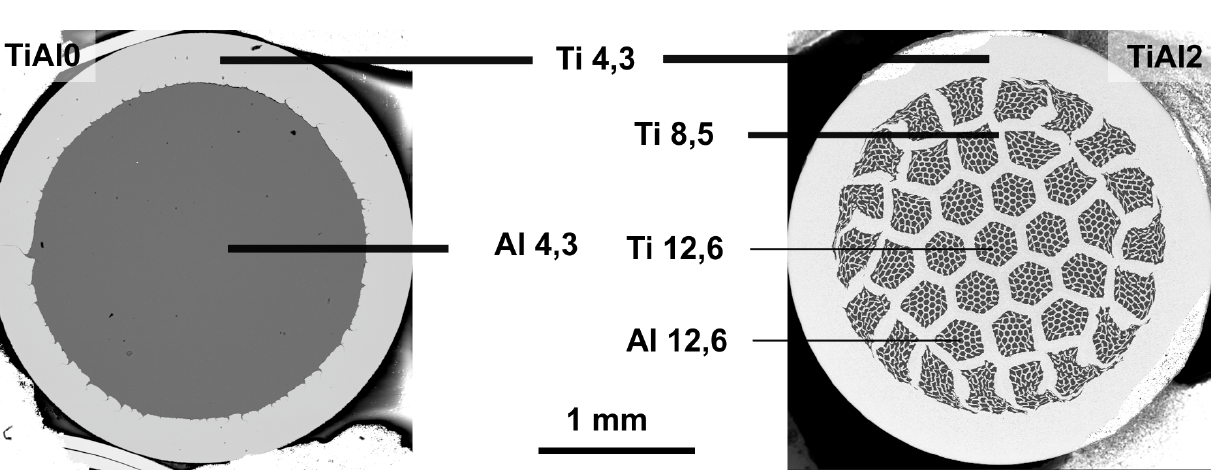
Figure 2. Visualization of the differently strained parts of the cross-section of the two composites, TiAl0 and TiAl2 (without stacking and two times stacked, respectively), in back scattered electron images. The given numbers correspond to the true strain of the cross-section